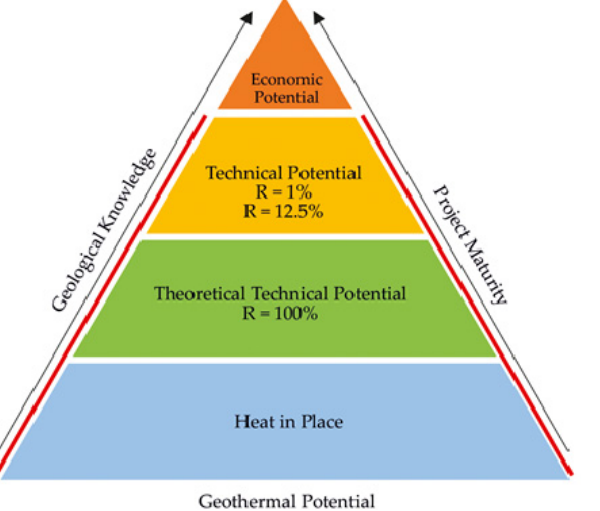
Figure 8. One-dimensional division of the geothermal potential classes—from theoretical to realistic—based on [131,132], modified.